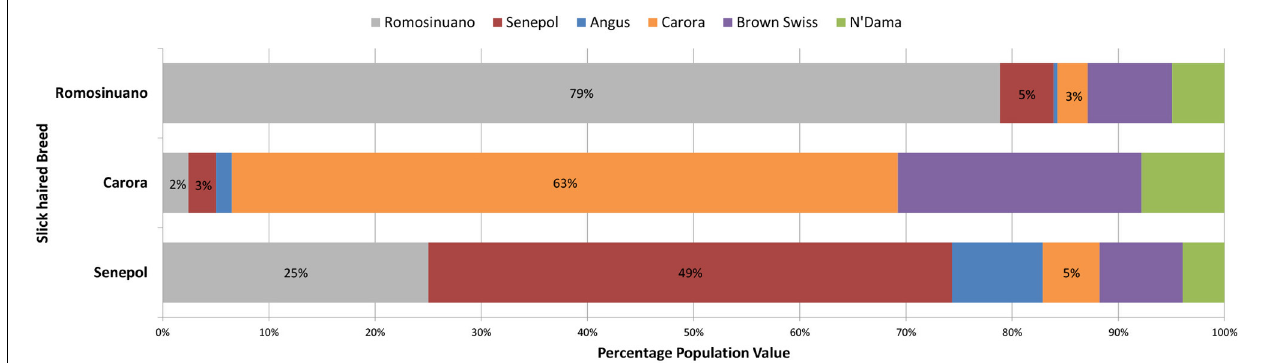
FIGURE 4 | The average genetic breed composition of Romosinuano, Carora, and Senepol when targeting SLICK . The three tropical slick-haired breeds were compared for their average breed composition using the ancestral breeds of Angus, Brown Swiss, Red Poll, N’Dama, and East Afrian Zebu as well as the three tropical breeds themselves to identify variation and relationship between the breeds at SLICK . At the optimal population differentiation value of K = 6, the Red Poll and East